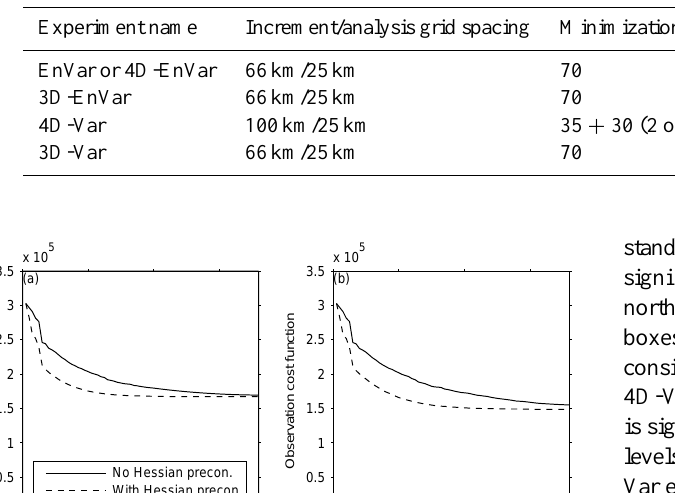
Table 1. Summary of experiments.